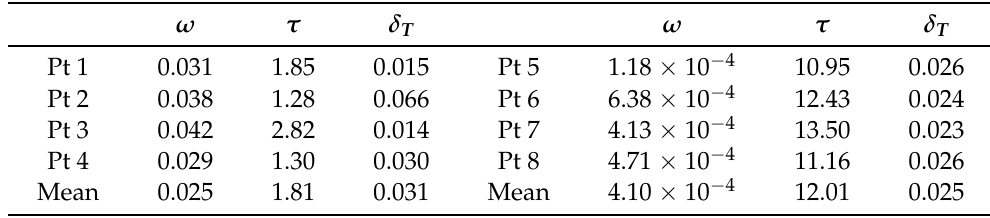
Table 4. Some parameter values in Model